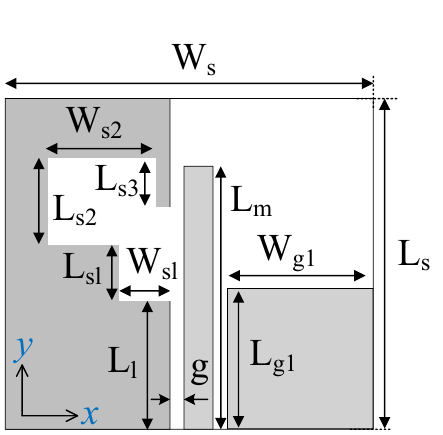
Figure 8. Wide-slot CP antenna 48 : parameterized view.